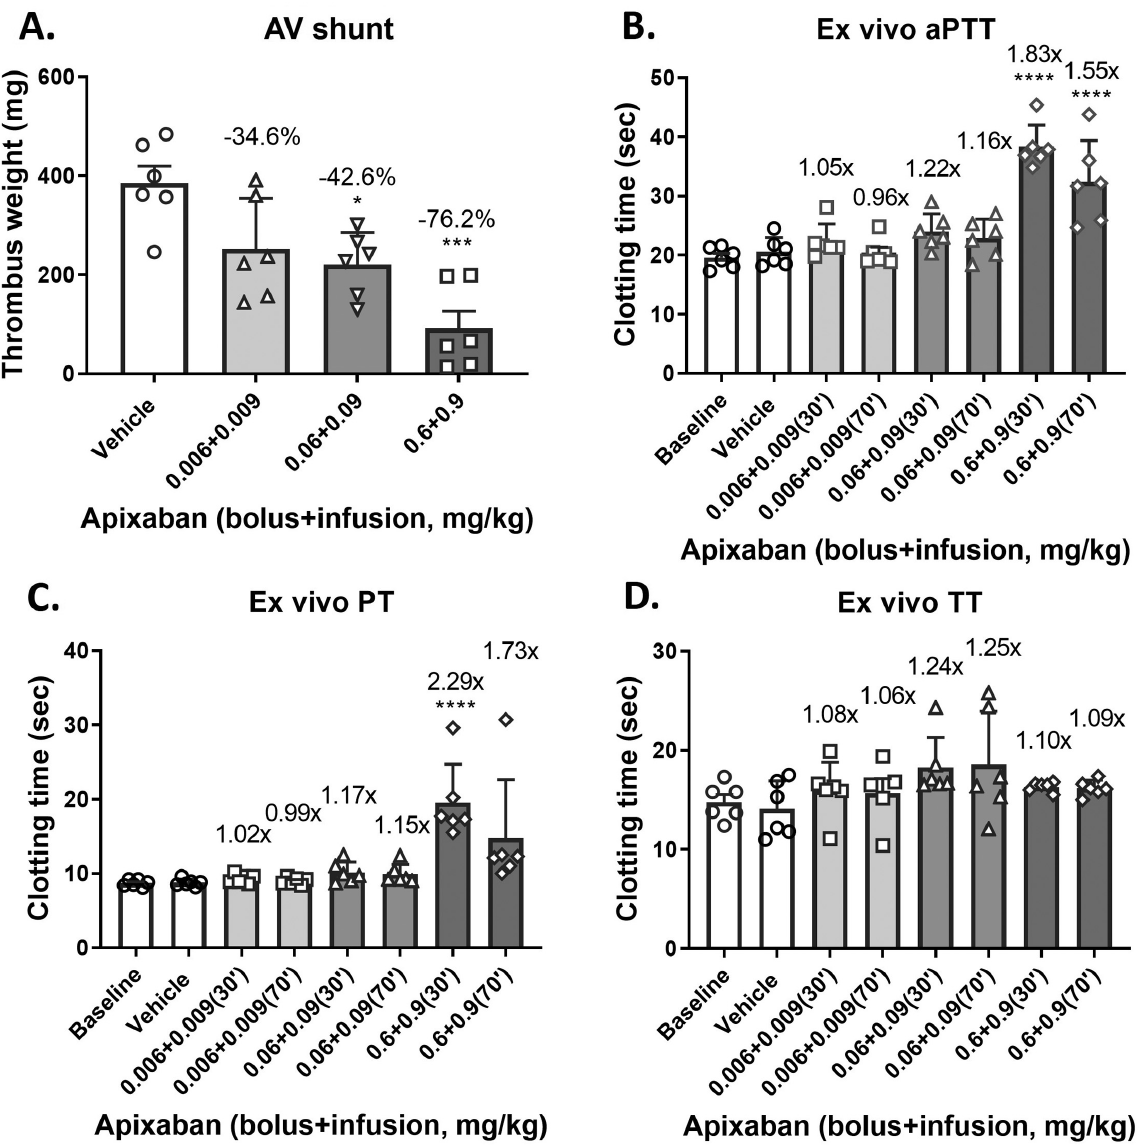
Fig. 2 Dose-dependent effects of apixaban on thrombus formation in the rabbit arteriovenous (AV) shunt model of thrombosis and ex vivo clotting. ( A ) Apixaban dose dependently reduced thrombus weight in the rabbit AV shunt model of thrombosis. Plasma samples were taken immediately prior to (30minutes after infusion) and after (at 70minutes) the AV shunt thrombosis and subjected to the ex vivo analysis of ( B ) activated partial thromboplastin time (aPTT), ( C ) prothrombin time (PT), and ( D ) thrombin time (TT). Each symbol in ( A ) represents 1 animal. Fold changes are indicated against vehicle in panels ( B ) and ( C ). (cid:4) p < 0.05. (cid:4)(cid:4)(cid:4) p < 0.001. (cid:4)(cid:4)(cid:4)(cid:4) p < 0.0001. Analysis of variance (ANOVA) followed by Tukey ’ s